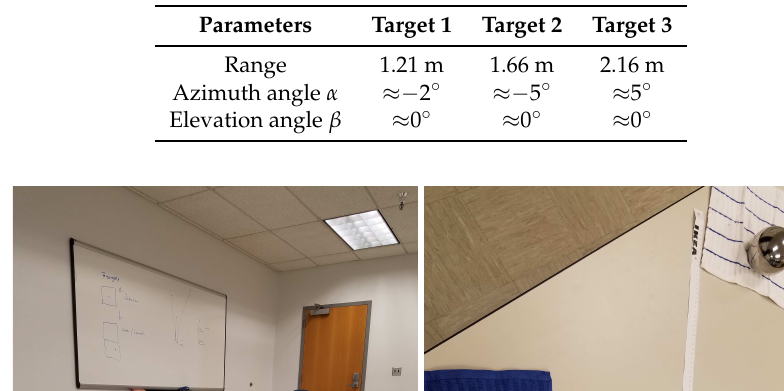
Table 3. Three ball targets’ scheme setup.